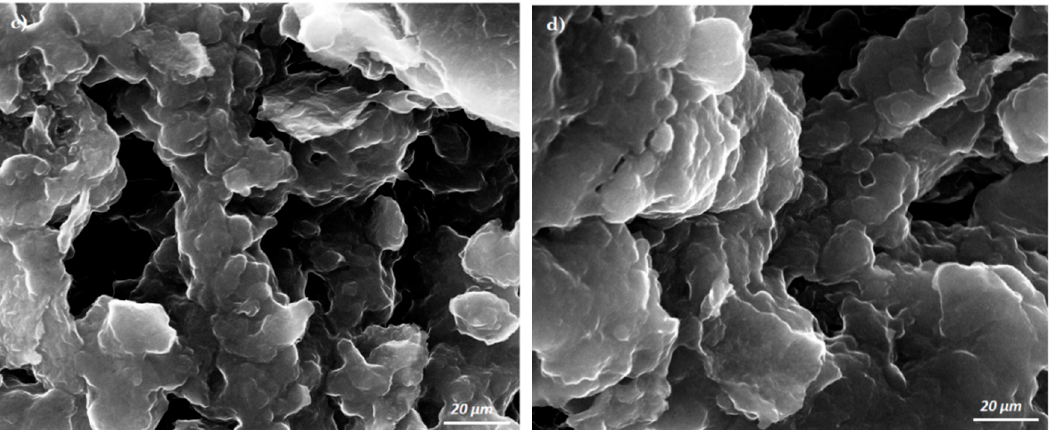
Figure 1. SEM micrographs of IN-AuNP-MWCNT ( a ), IQ-AuNP-MWCNT ( b ), HD-AuNP-MWCNT ( c ), and TEX-AuNP-MWCNT ( d ).